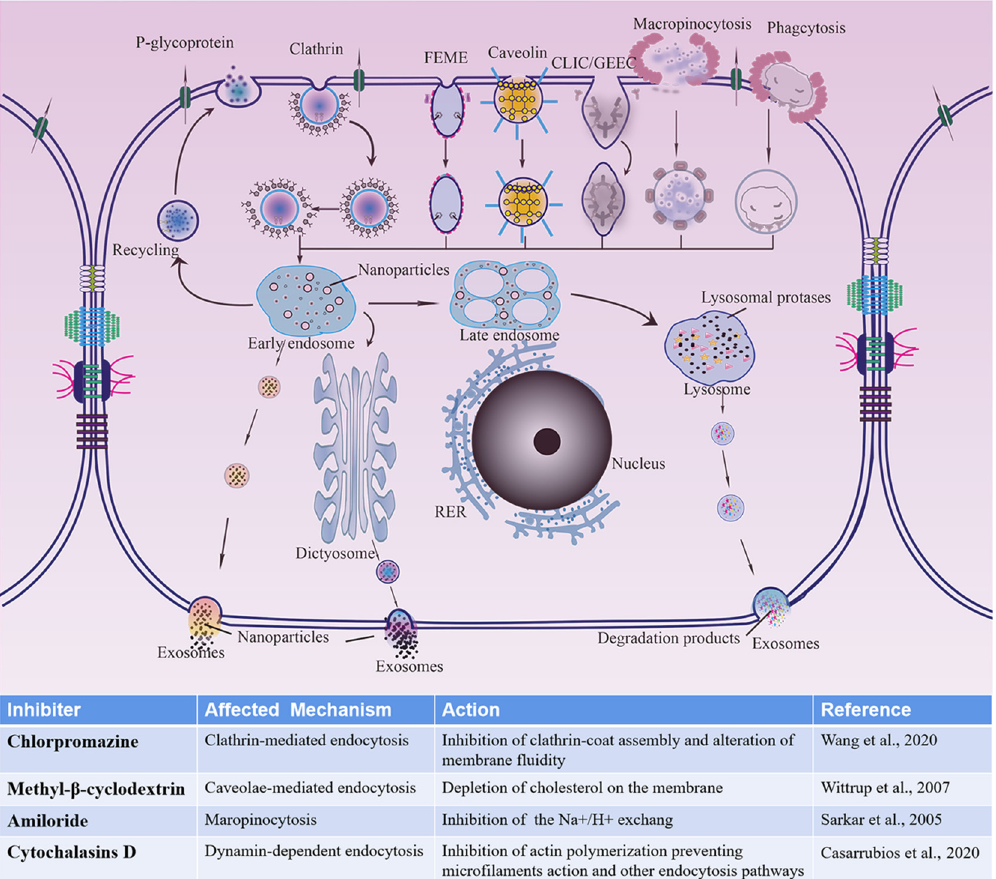
Figure 6. Schematic diagram about cellular uptakes of CsA-NCs into Caco-2 cells and inhibitory effects of several endocytosis inhibitors. FEME: clathrin-independent/dynamin-dependent endocyto- sis; CLIC/GEEC: clathrin-independent/dynamin-independent endocytosis; RER: rough endoplasmic reticulum. Wang et al., 2020 [25], Wittrup et al., 2007 [48], Sarkar et al., 2005 [49], Casarrubios et al., 2020 [50].